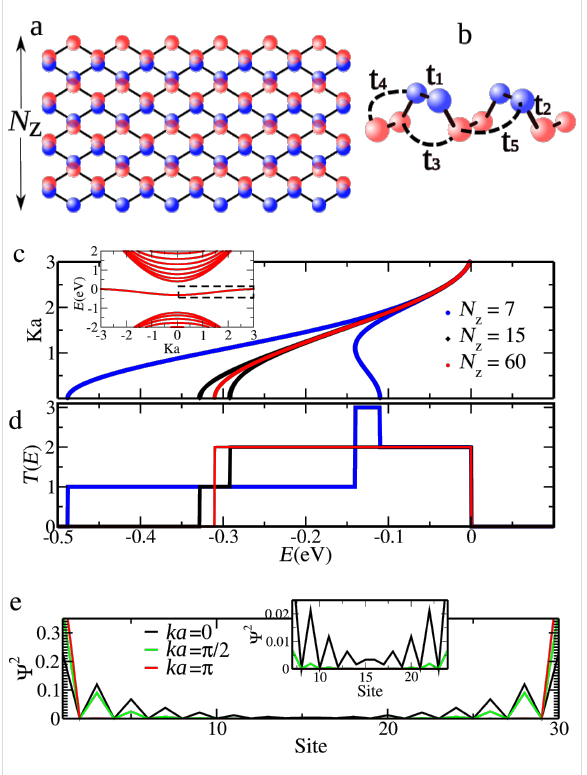
Figure 1: (a) Illustration of a zigzag phosphorene nanoribbon of width N Z , where N Z is the number zigzag chains. (b) Hopping parameters used in the four-band model [20]. (c) Structure of the central band of edge states of nanoribbons with different widths. The inset includes the band structure of the bottom and top of the conduction and valence bands for N Z = 60. (d) Transmission probabilities for the edge states depicted in panel (c). (e) Probability amplitude of edge states for N Z = 15 for different values of ka . The inset reveals the stronger non- zero overlapping of states of the two edges at the bottom of the central band, ka =